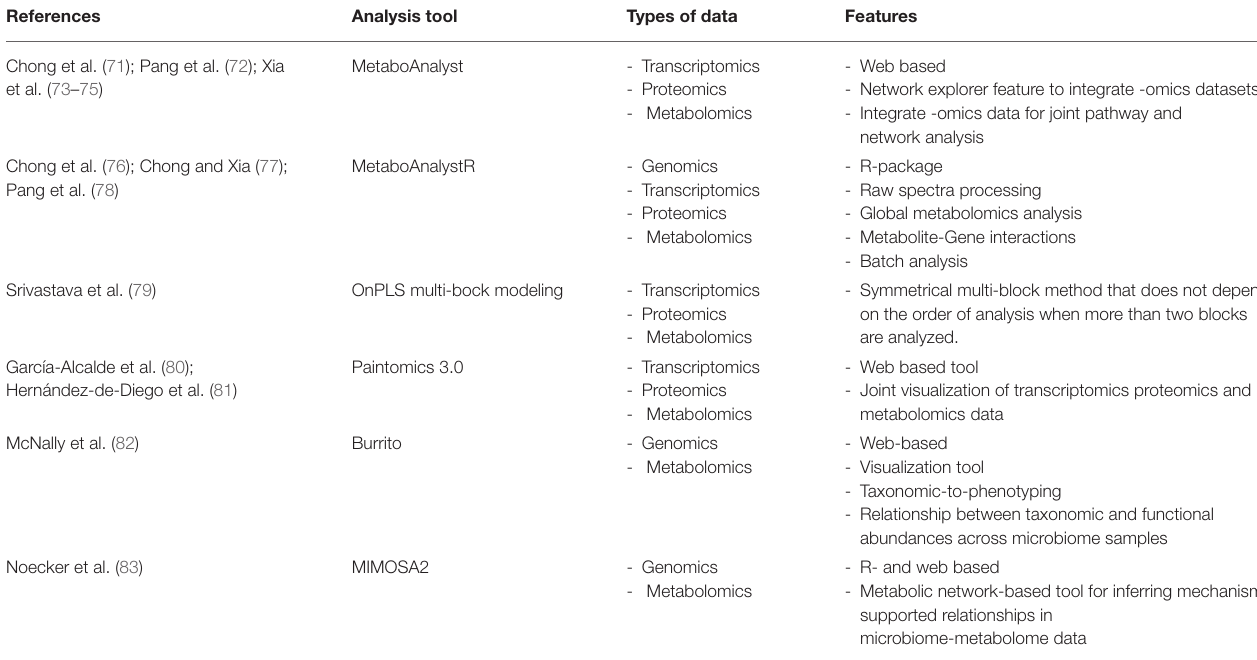
TABLE 2 | Summary of -omic data integration analysis